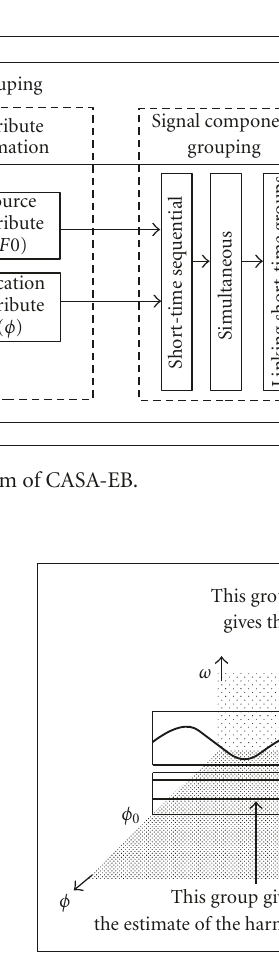
Figure 3: Separated signals from a two-signal mixture. This figure shows separated signal component groups from an example mixture signal—the sum of the two signals shown in Figure 2. The signal component groups are formed by collecting together signal components with similar location and source attributes (details in Section